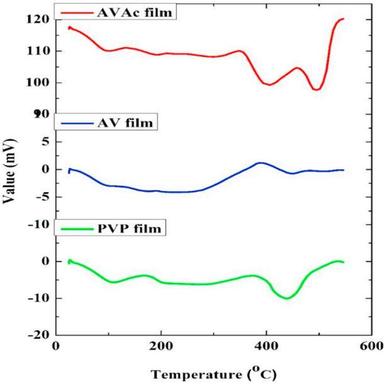
DSC thermogram of Av/PVP and AvAc/PVP nanofibers.